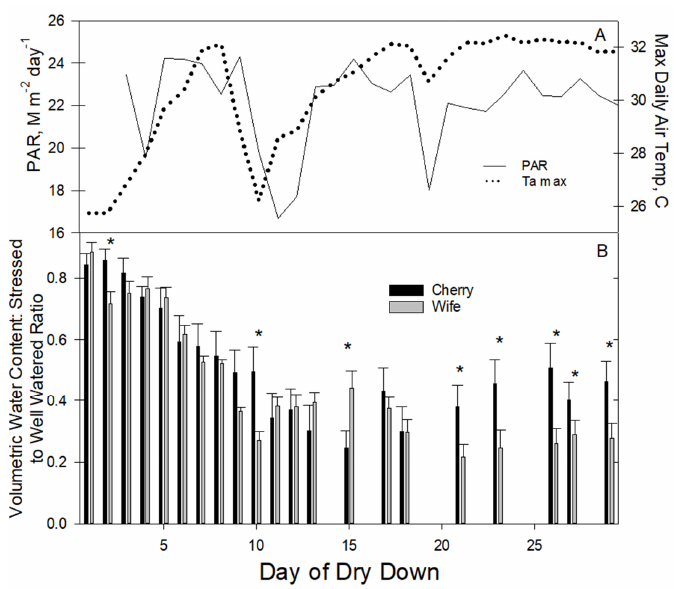
Figure 3. Dry down of two hemp varieties showing climate (A; cumulative incoming daily photo- synthetically active radiation [PAR] and maximum daily air temperature [Ta max]) and concurrent decline in root zone water content (B)of two varieties of container-grown hemp., Bars show the ratio water stressed water content as a fraction of well-watered plants for the two hemp varieties, ‘Cherry’ and ‘Wife’ during the study of progressive root zone water depletion and subsequent steady-state water stress. Standard deviation bars are pooled across wet and dry treatments within a cultivar ( n = 8). Asterisks above the daily data point are signi fi cantly di ff erent at p < 0.05 ( n = 4).